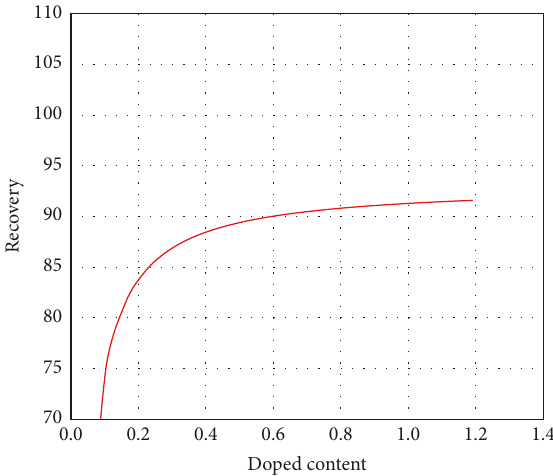
Figure 8: Linear weighted regressions for the matrices lip gloss, lip balm, and lipstick. Plot: MOAH recovery (%) as a function of spiked content of MOAH in g/100 g.